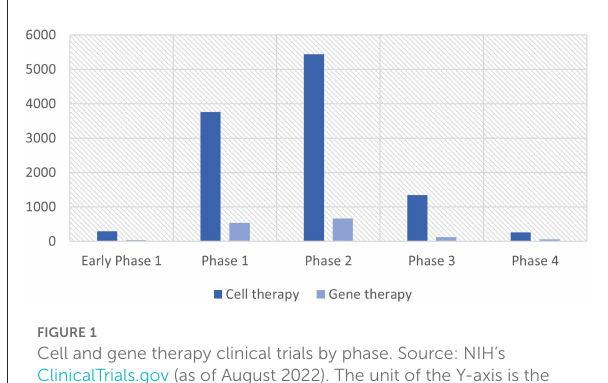
FIGURE1 Cell and gene therapy clinical trials by phase. Source: NIH’s ClinicalTrials.gov (as of August 2022). The unit of the Y-axis is the number of clinical